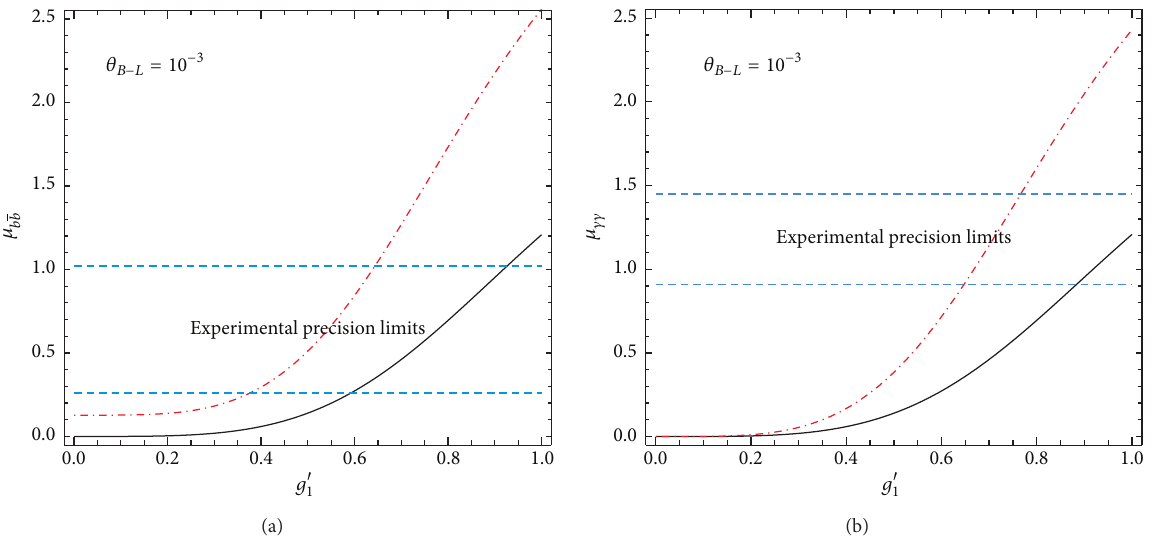
Figure 11: Higgs signal strengths 𝜇 𝑖 ( 𝑖 = 𝑏𝑏,𝛾𝛾 ) for the process 𝑒 + 𝑒 − → 𝑍ℎ as a function of 𝑔 󸀠 1 . The dashed lines represent the experimental precision limits and the solid and dot-dashed lines correspond to the 𝑈( 1 ) 𝐵−𝐿 model with 𝑀 ℎ = 125 GeV and √𝑠 = 500 , 1500 GeV,